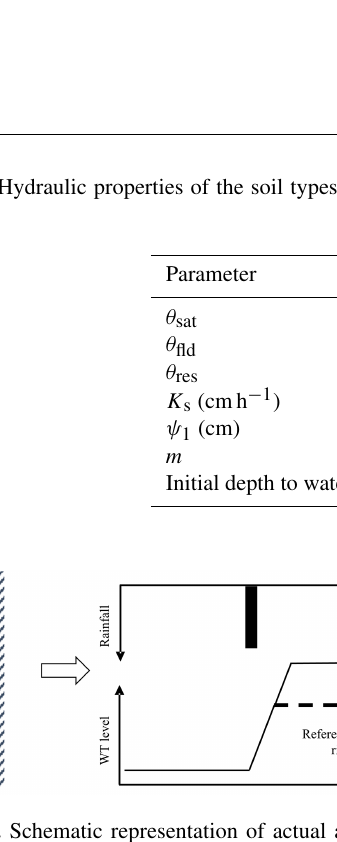
Applicable in both deep and shallow water table regions. The dynamic vari- ations in the specific yield in shallow time step water table regions are handled using the UZ–SZ coupling approach. How- ever, the iterative process increases the computational burden of the model. Since the specific yield is assumed to be constant, it has limitations in mod- elling the water table fluctuations of the humid regions. The simplified UZ– SZ coupling approach makes the model computationally efficient.